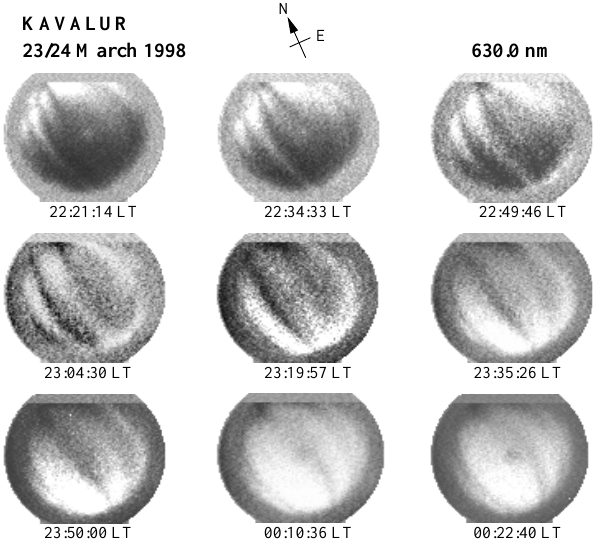
Fig. 6. Plasma depletions in the 630nm images taken over Kavalur on the night of 23/24 March 1998. The arrow points towards the geomagnetic north.